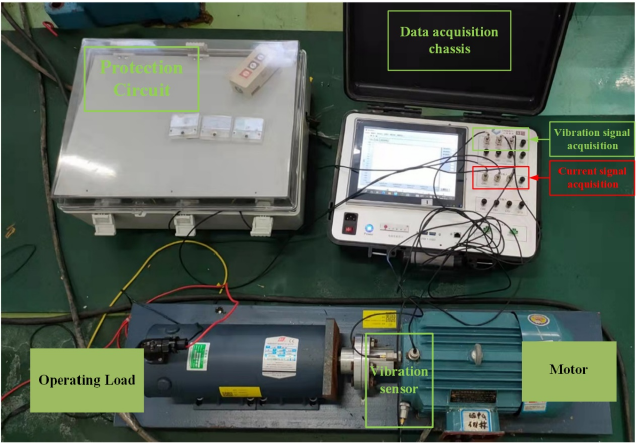
Figure 6. Experiment Platform.